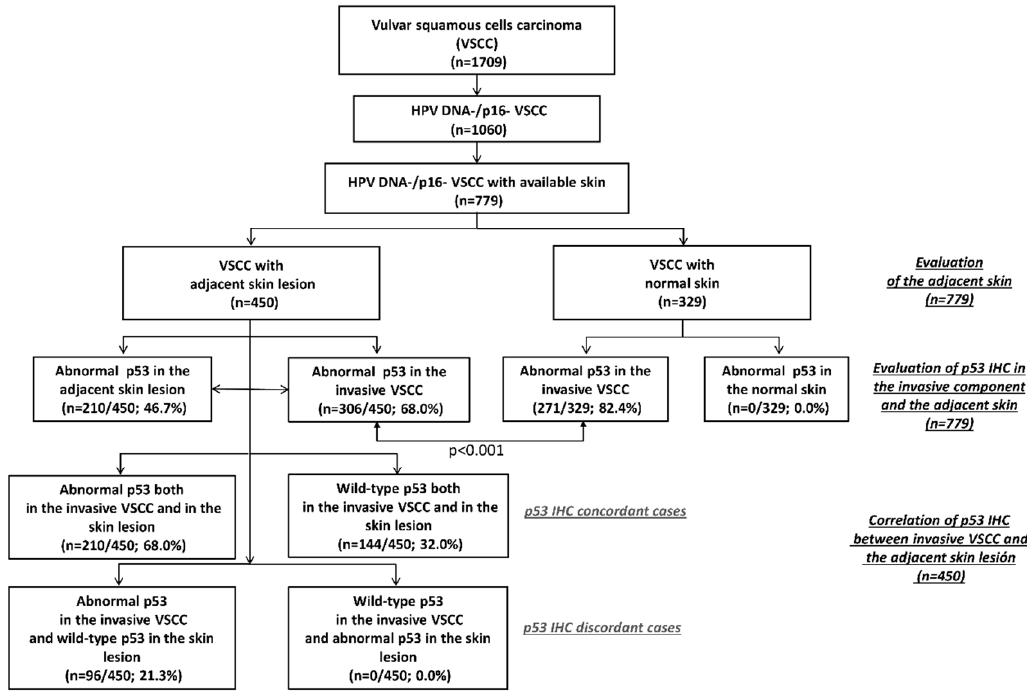
Figure 4. The study algorithm and results of histological and p53 immunohistochemical (IHC) evaluation of the adjacent skin and invasive vulvar squamous cell carcinoma (VSCC).